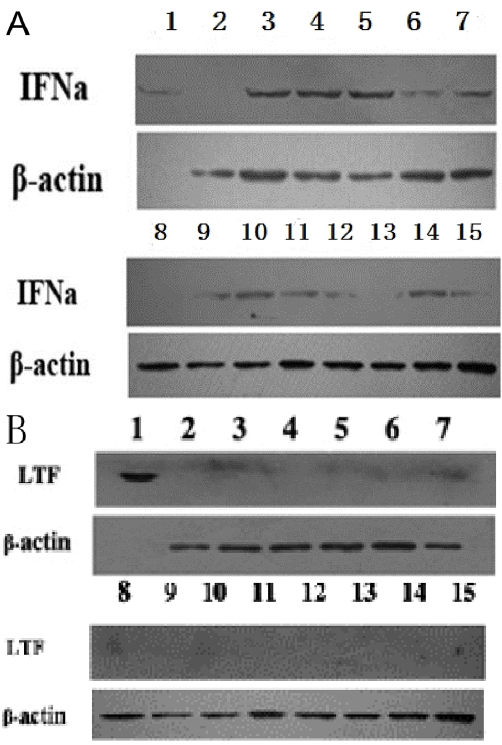
Figure 2. Detection of hIFN- a and LFCIN B (LTF) protein expression in transfected donor cells (transfected bovine fetal fibroblasts) and tissues from the transgenic calf generated by somatic cell nuclear transfer (SCNT). The hIFN- a (A) and LFCIN B (B) protein expression was determined by western blot. Lane 1 in (A), recombinant human IFN- a 2b protein as positive control. Lane 1 in (B), lactoferricin B as positive control; lanes 2 and 8, the same wild-type bovine fetal fibroblasts, as negative controls; lane 3, transfected bovine fetal fibroblast clone 1; lane 9, transfected bovine fetal fibroblast clone 2; lane 4, liver; lane 5, lung; lane 6, spleen; lane 7, heart; lane 10, ear skin; lane 11, muscle; lane 12: stomach; lane 13: intestine; lane 14: colon; lane 15: kidney.